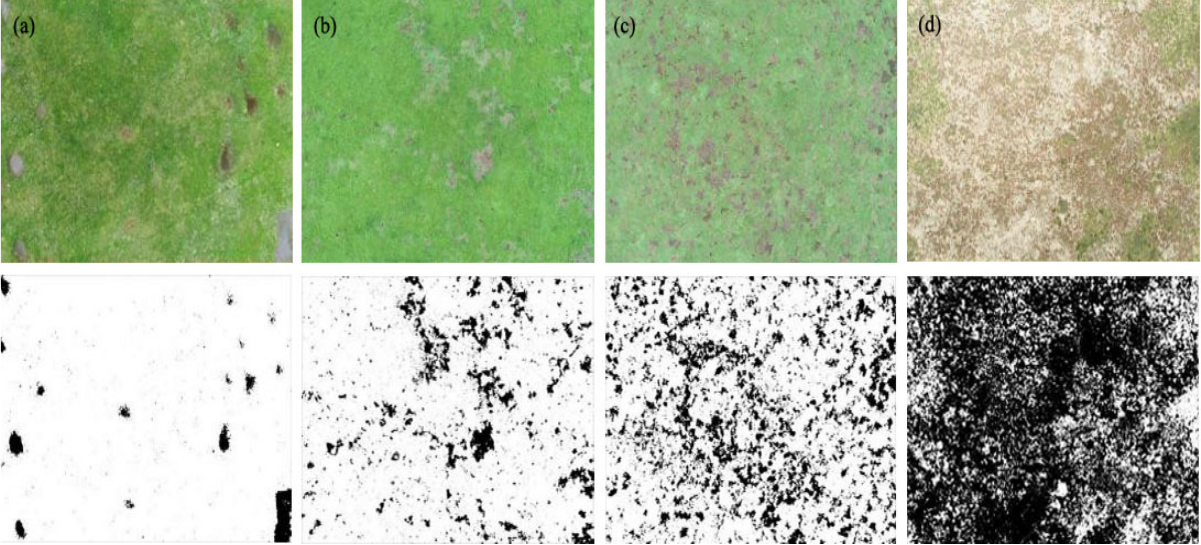
Figure 2. Drawing of patch extraction effect of four grassland types (a: swamp meadow; b: alpine meadow; c: degraded meadow; d: alpine